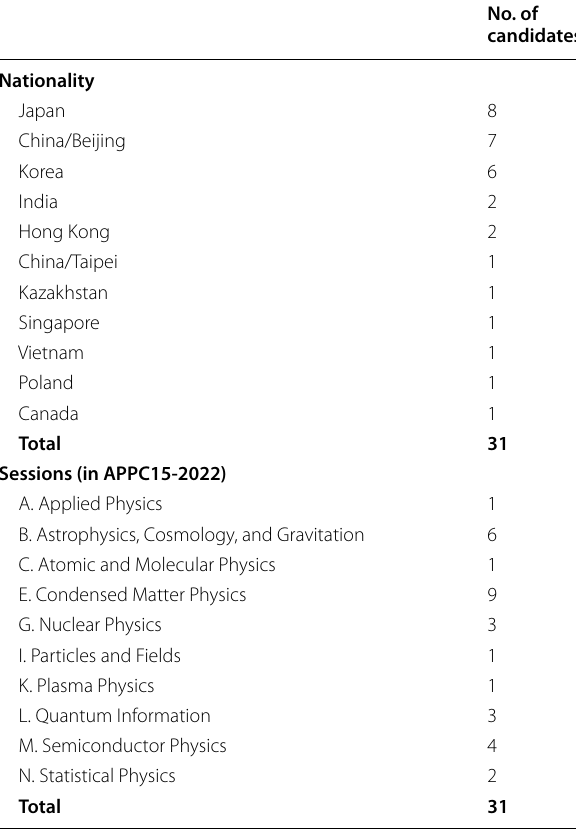
Table 1 The nationalities and the sessions of the 2022 C.N. Yang Award